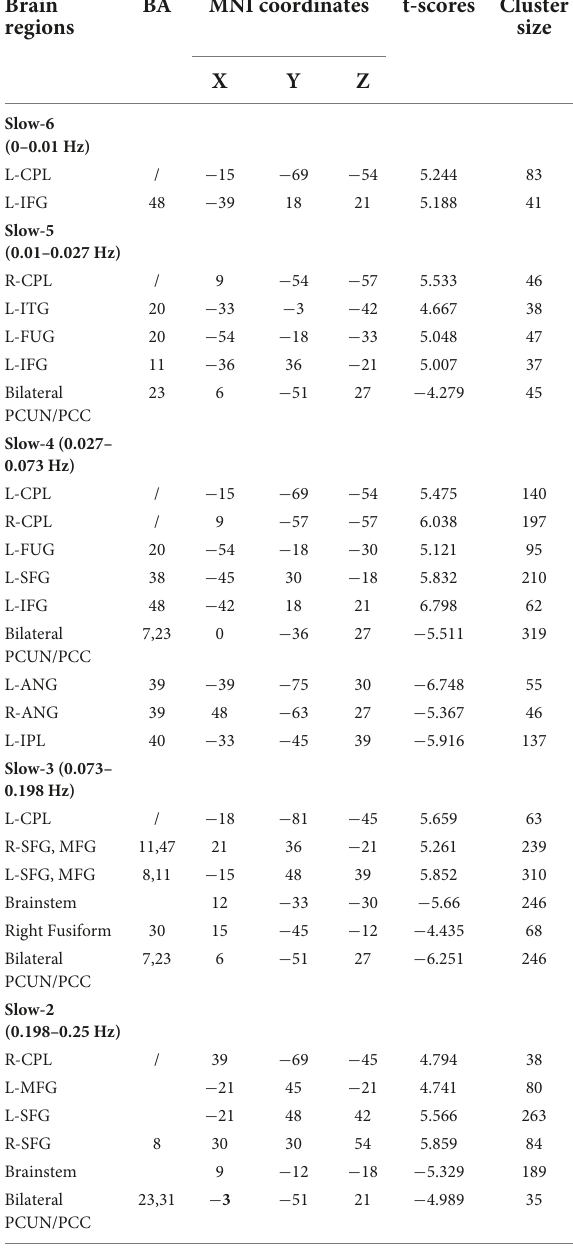
TABLE 4 Significant alterations of the ALFF of five specific frequency bands between the OSA patients and HCs. Brain BA MNI coordinates t-scores Cluster regions